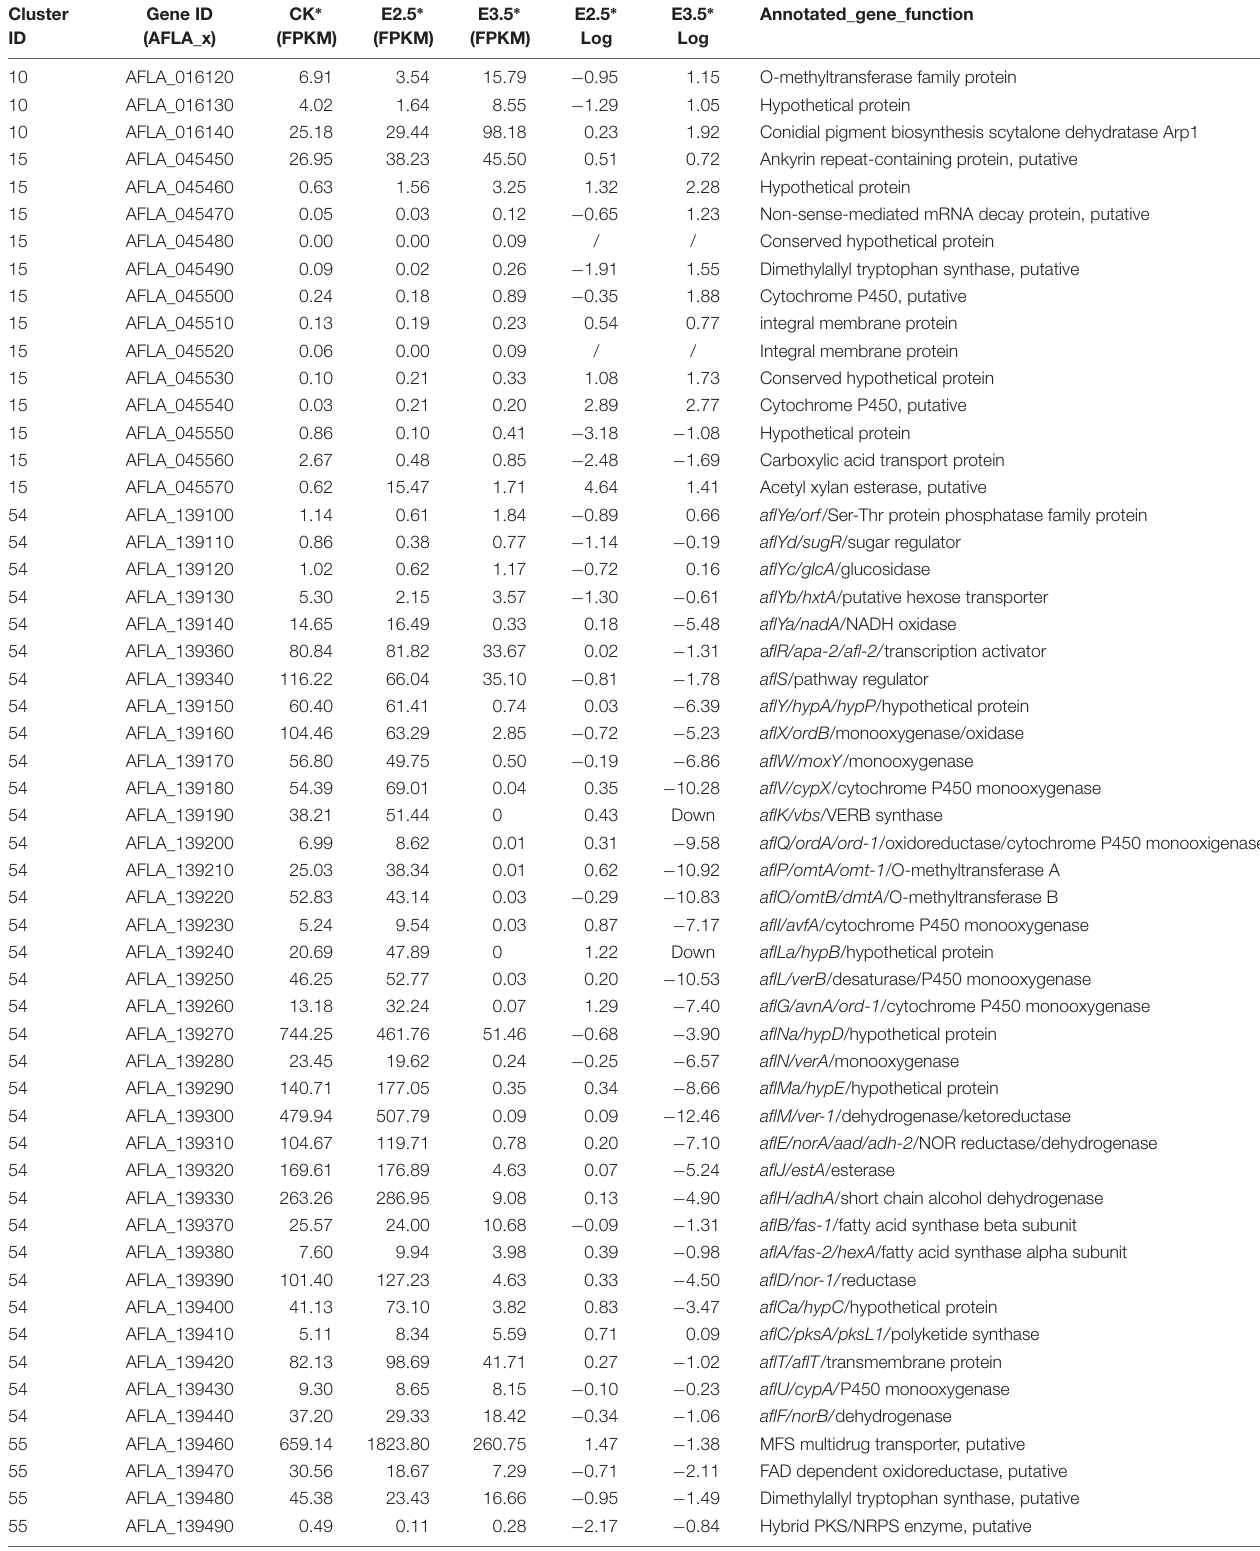
TABLE 1 | Transcriptional activity of genes in the biosynthesis of conidial pigment (#10), aflatrem (#15), aflatoxin (#54), and cyclopiazonic acid (#55). Cluster